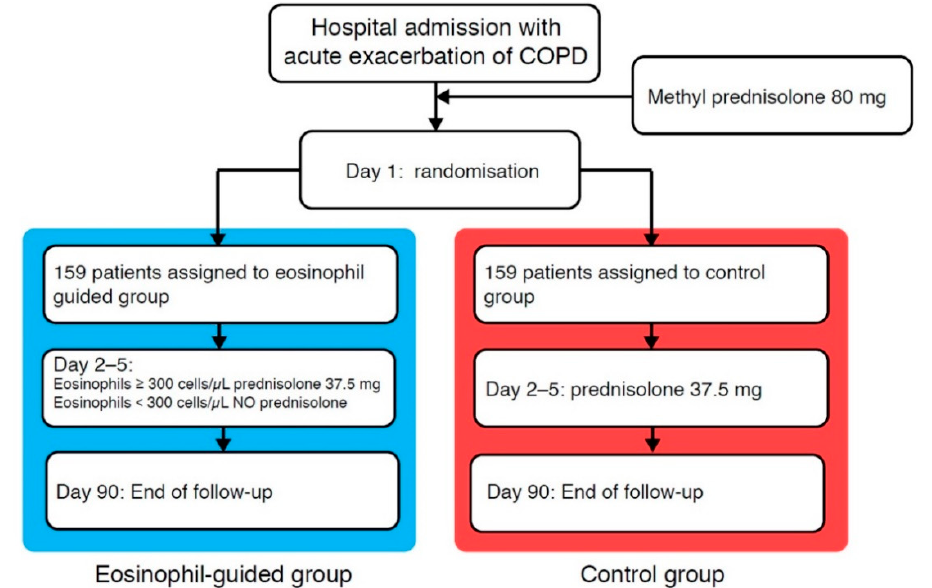
Figure 1. Treatment algorithm from the CORTICO-COP trial—adapted from Sivapalan et al. Abbreviation: COPD, chronic obstructive pulmonary disease.